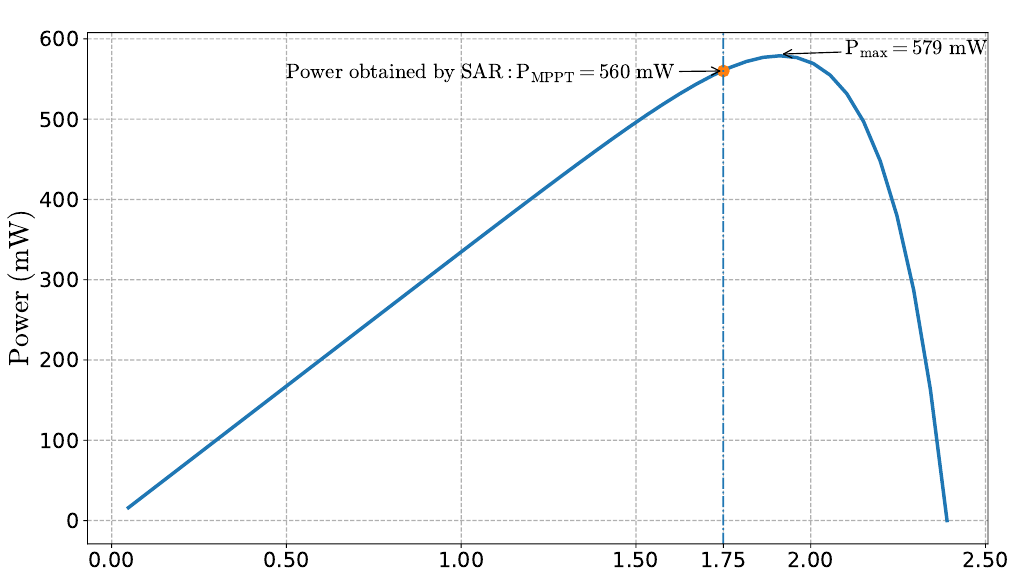
Figure 13. Evaluation of MPPT performance by comparison the power obtained and the maximum available